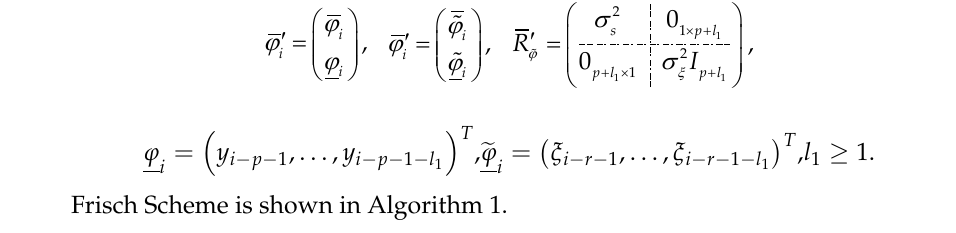
Algorithm 1. Frisch Scheme